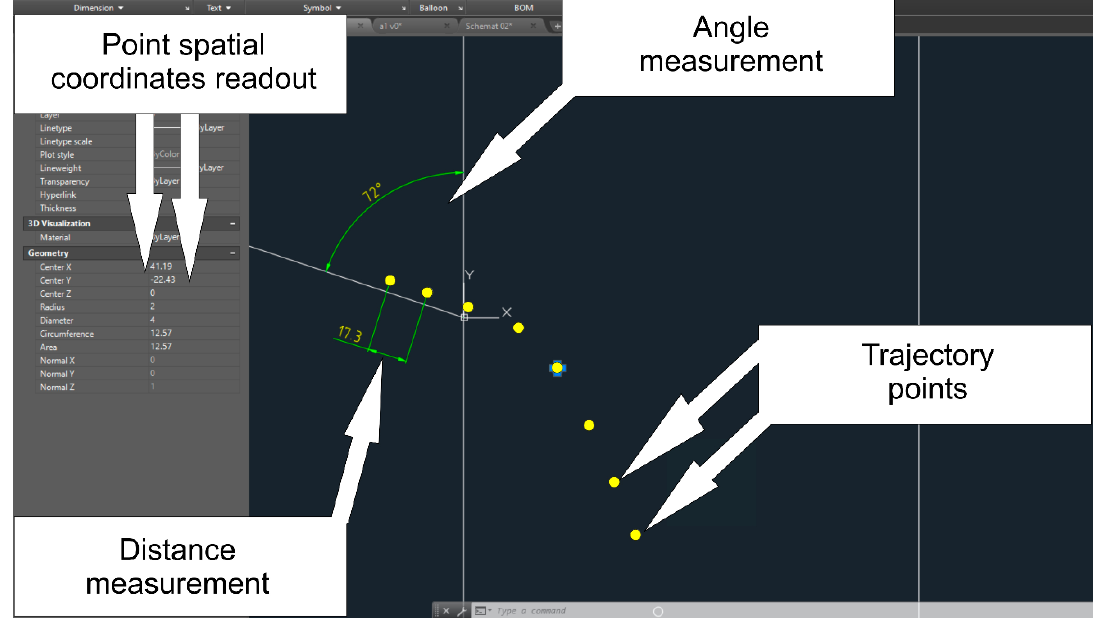
Figure 9. The outline of the trajectory and the method of conducting the measurements on the basis of the registered video stream.